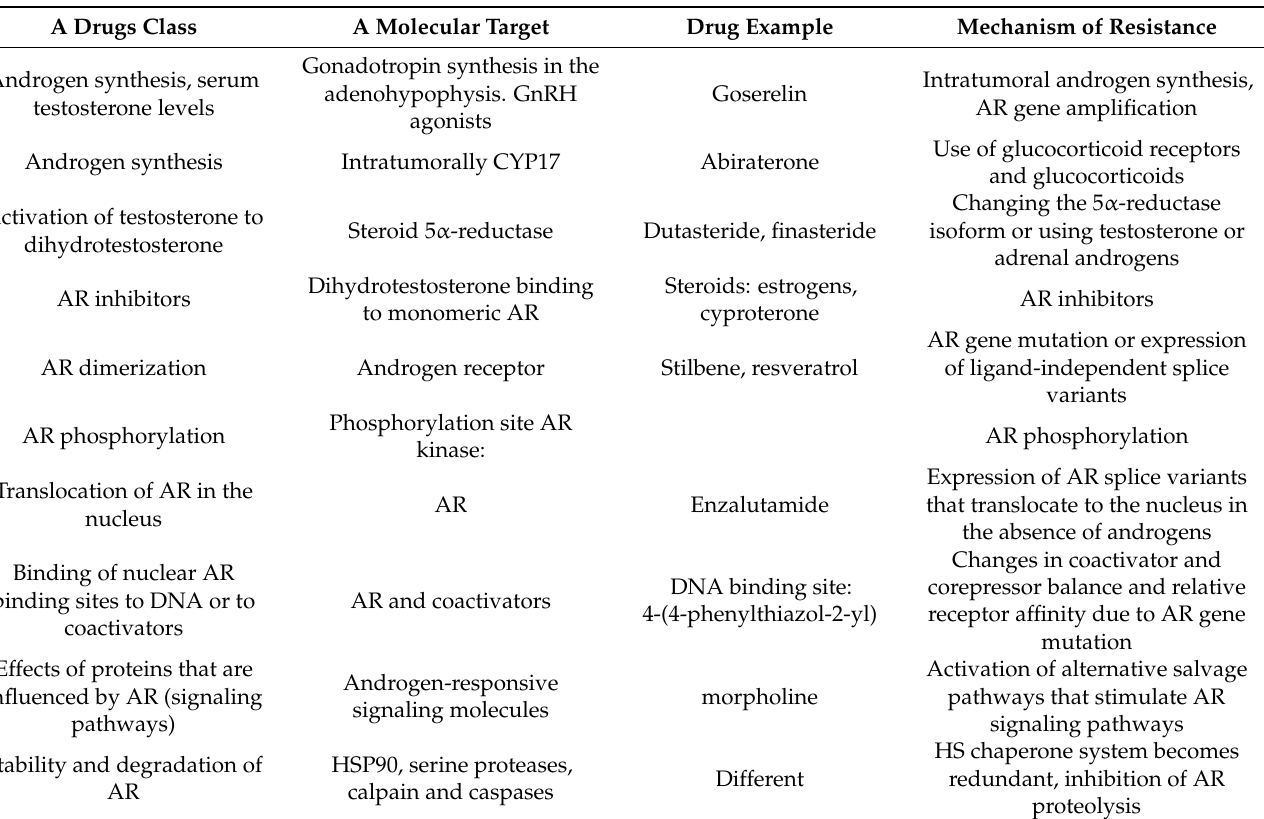
Table 2. Inhibition of transduction mechanisms related to androgen receptors under the influence of small